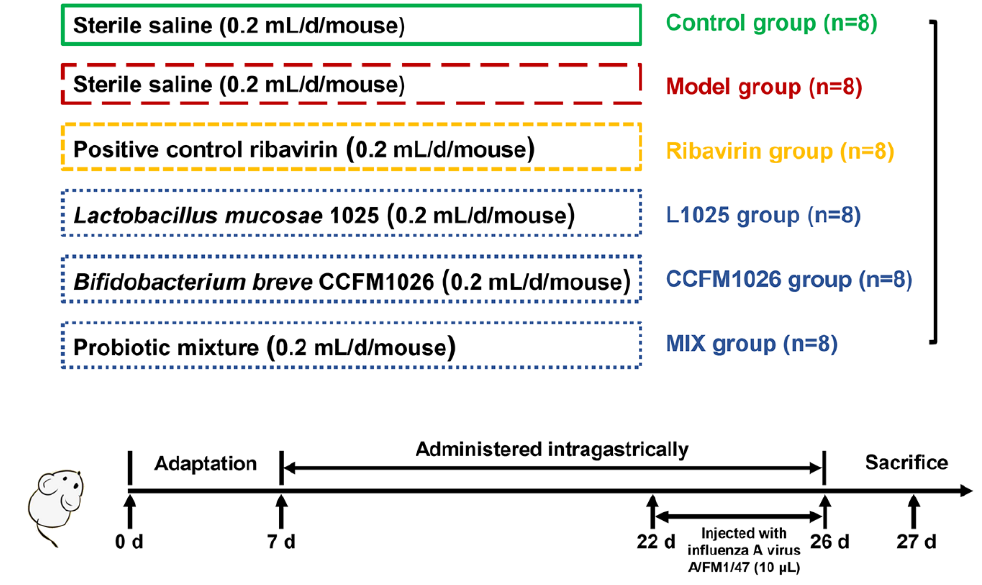
Figure 1. The flow of animal experiment.